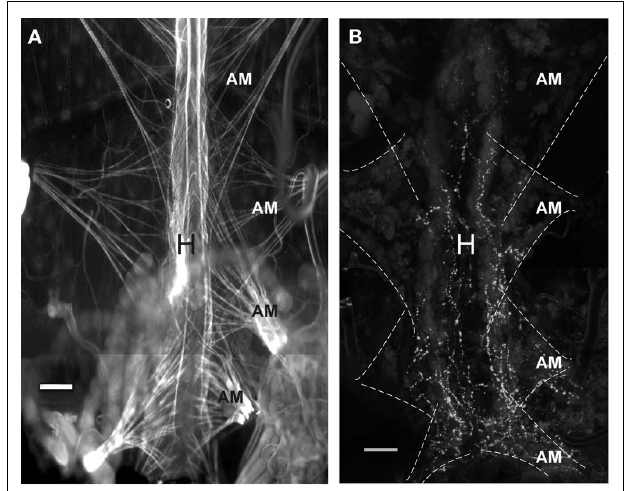
FIGURE 9 |The effect of proctolin on spontaneous contractions of the hindgut of fifth instar R. prolixus . A sample trace (A) illustrates that proctolin leads to an increase in frequency and basal tonus of hindgut contractions. Upward arrows indicate addition of proctolin, downward arrows indicate vigorous, repeated washing with physiological saline. Dose–response curves show the total tension in mg (B) and the percent change in basal tonus of hindgut contractions relative to maximum change (C) . Data are mean ± SE, n =